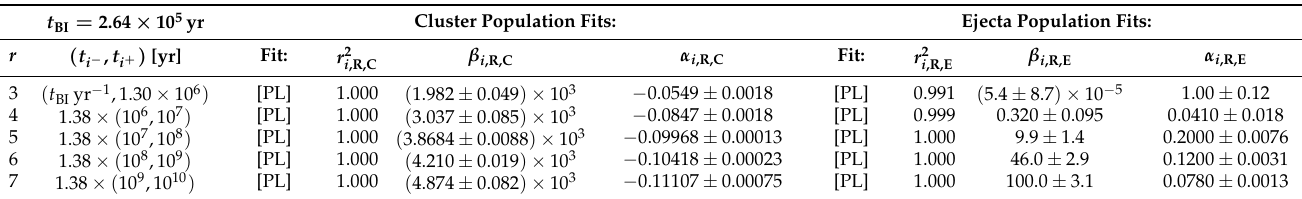
Table 5. Mean remaining in-cluster and in-ejecta object population PL fits of Figure 8 from Equation (31): N P ( t ∈ r ) = β i ,P t α i ,P . α i ,P is the PL index, and corresponds roughly to the constant value of the differential counts, while β i ,P in turn, corresponds to the amplitude of the PL, r = 3, . . . ,7 refers to the separate run where the fit is performed and P = ( R,C ) , ( R,E ) denotes the remaining cluster and ejecta populations respectively.